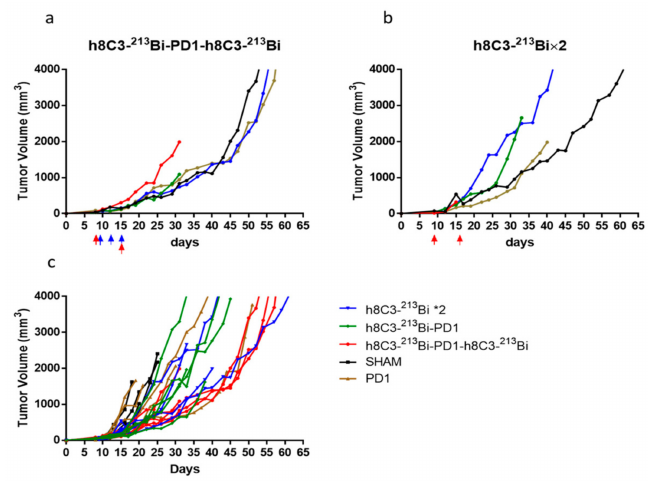
Figure 3. Combination therapy of Cloudman S91 tumor bearing male DBA / 2 mice with anti-PD-1 mAb and two doses RIT with 213 Bi-h8C3 mAb. The mice in groups of five were treated with: ( a ) two doses of 400 µ Ci 213 Bi-h8C3 given on Days 8 and 15 and three doses of anti-PD-1 mAb given on Days 8, 11, and 15; ( b ) two doses of 400 µ Ci 213 Bi-h8C3 given on Days 9 and 16; ( c ) combined plot for all treatment groups. Each tumor volume curve represents a single animal. Blue and red arrows indicate the injection of anti-PD1 antibody and RIT, respectively.